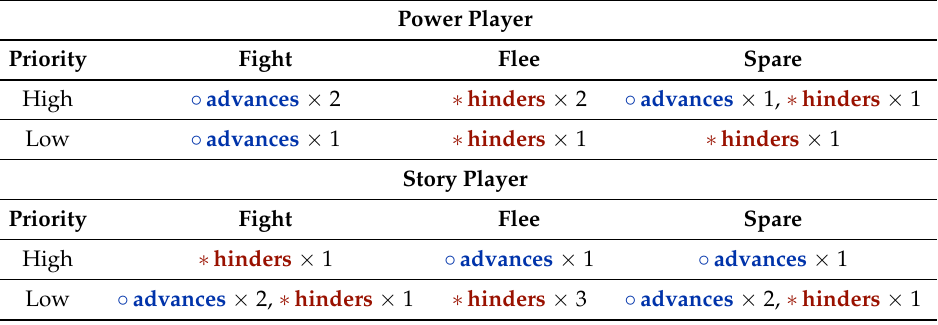
Table 3. Option analysis results from the right-hand (post-hoc) side of Table 2, grouped according to player models, options, and goal priorities. This illustrates at a high level how (after exploring each option) the power player is encouraged to fight “monsters” while the story player is encouraged to spare